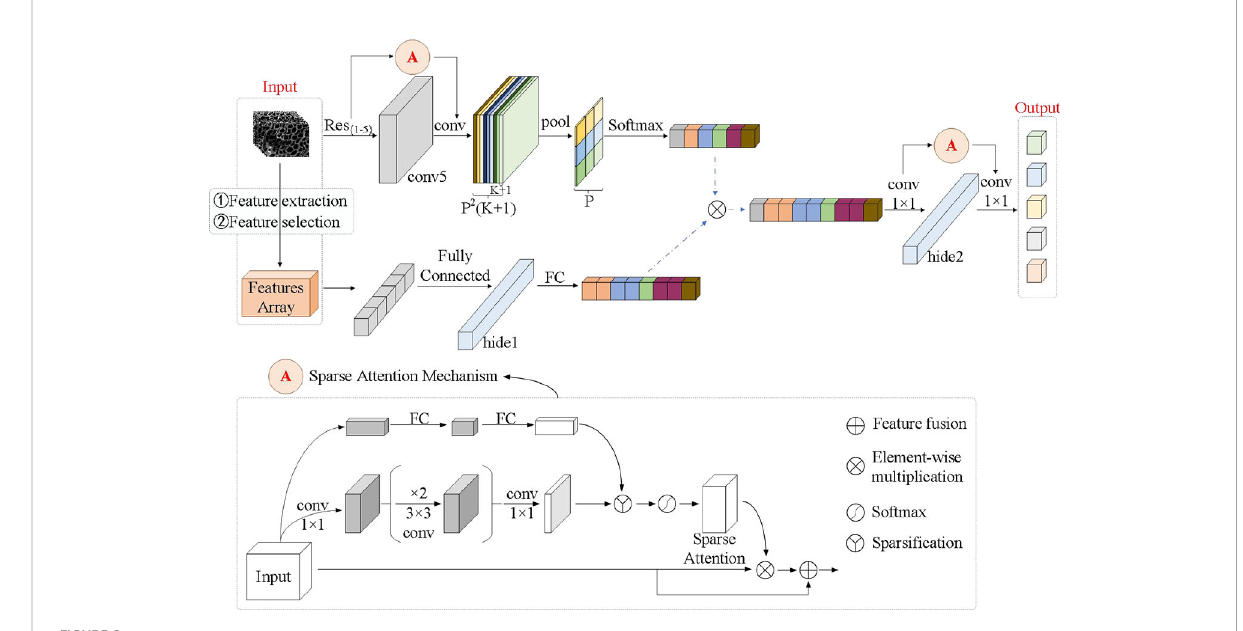
FIGURE 8 D-SA-FCN network model structure.